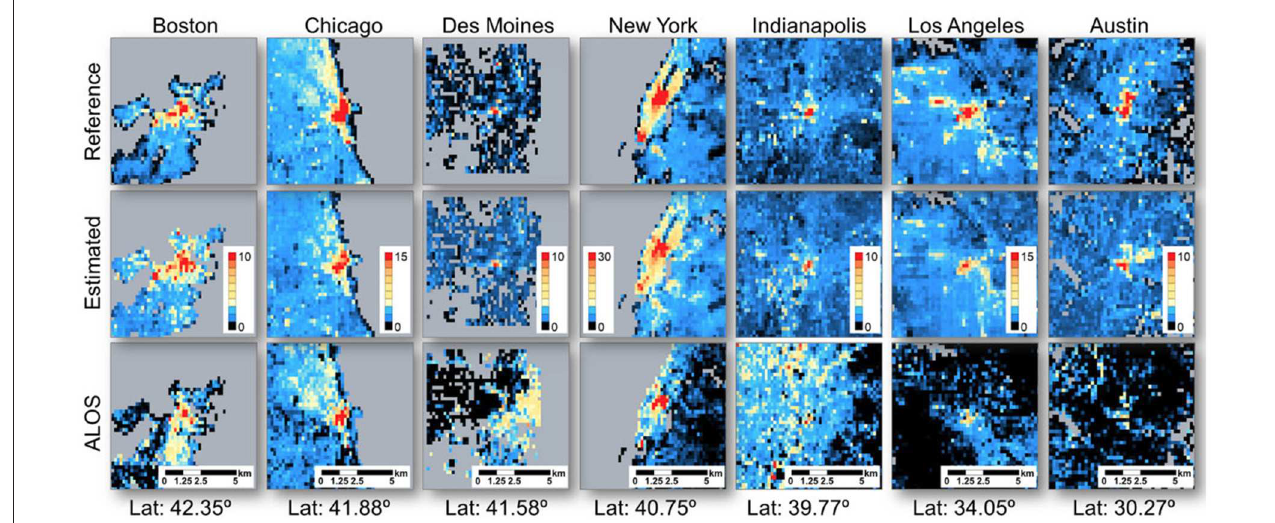
FIGURE 5 | Estimated spatial patterns in building heights in seven U.S. cities using Sentinel-1 data, compared to reference (non-satellite) measurements and Advanced Land Observing Satellite (ALOS) data (unit: m). Measurements are presented at 500 m resolution with a spatial extent of 20 × 20 km. Areas outside the study domain are colored as gray. [Credit: Li et al.